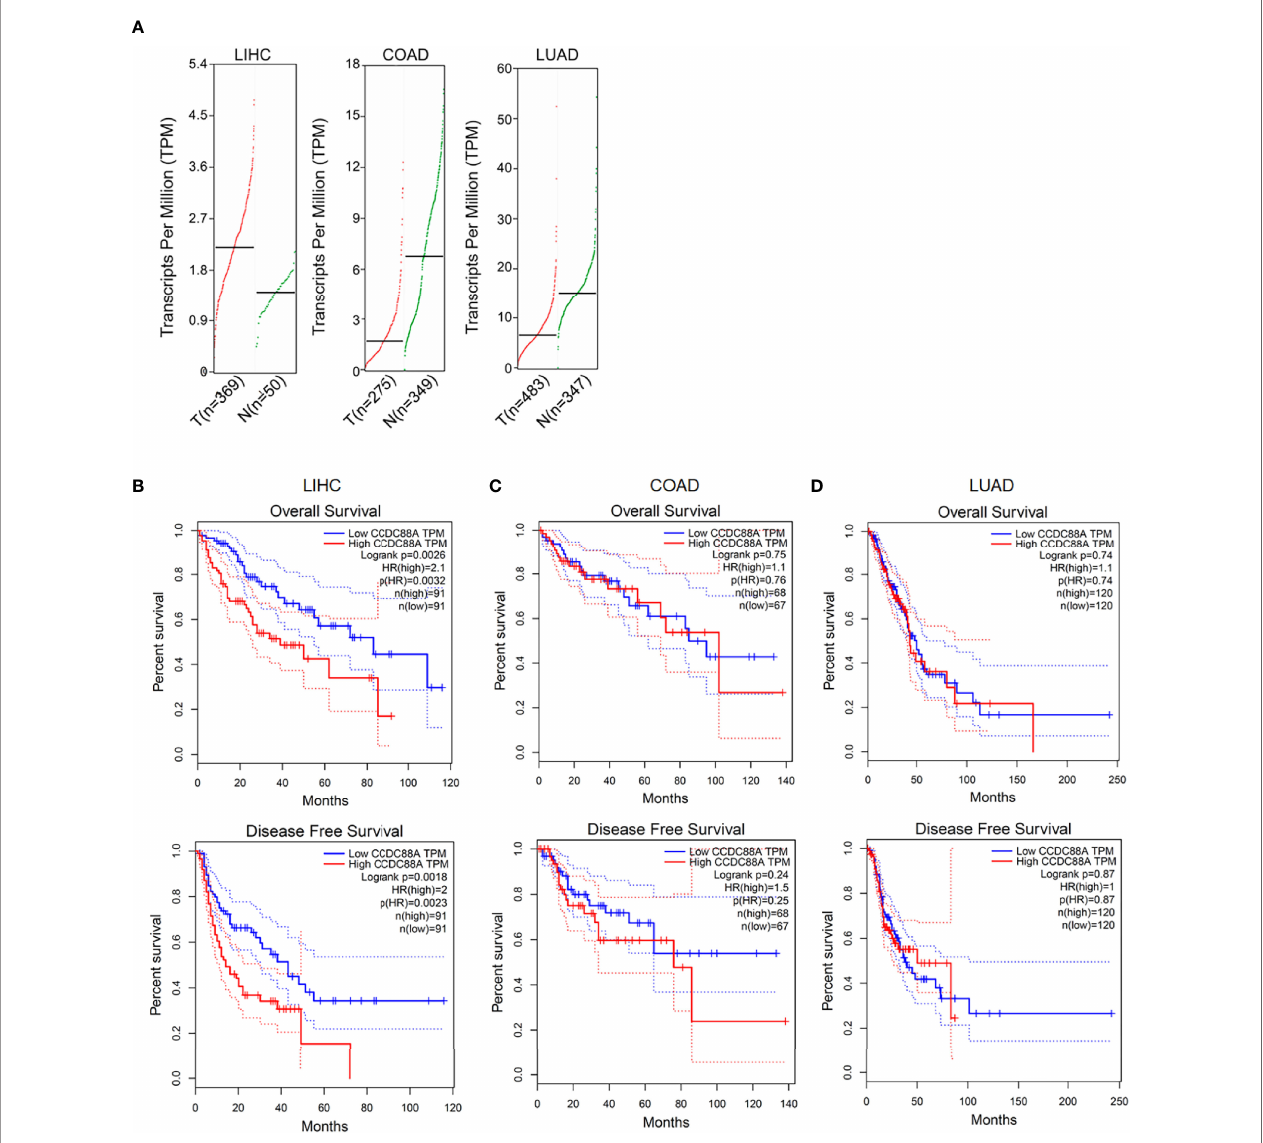
FIGURE 1 | Expression of CCDC88A in human cancers determined by GEPIA database. (A) The expression pro fi le of CCDC88A in three major human cancers, including Liver hepatocellular carcinoma (LIHC), colorectal adenocarcinoma (COAD), and lung adenocarcinoma (LUAD). Overall survival analysis and disease-free survival analysis of CCDC88A in LIHC (B) , COAD (C) , and LUAD (D) were determined by employing GEPIA